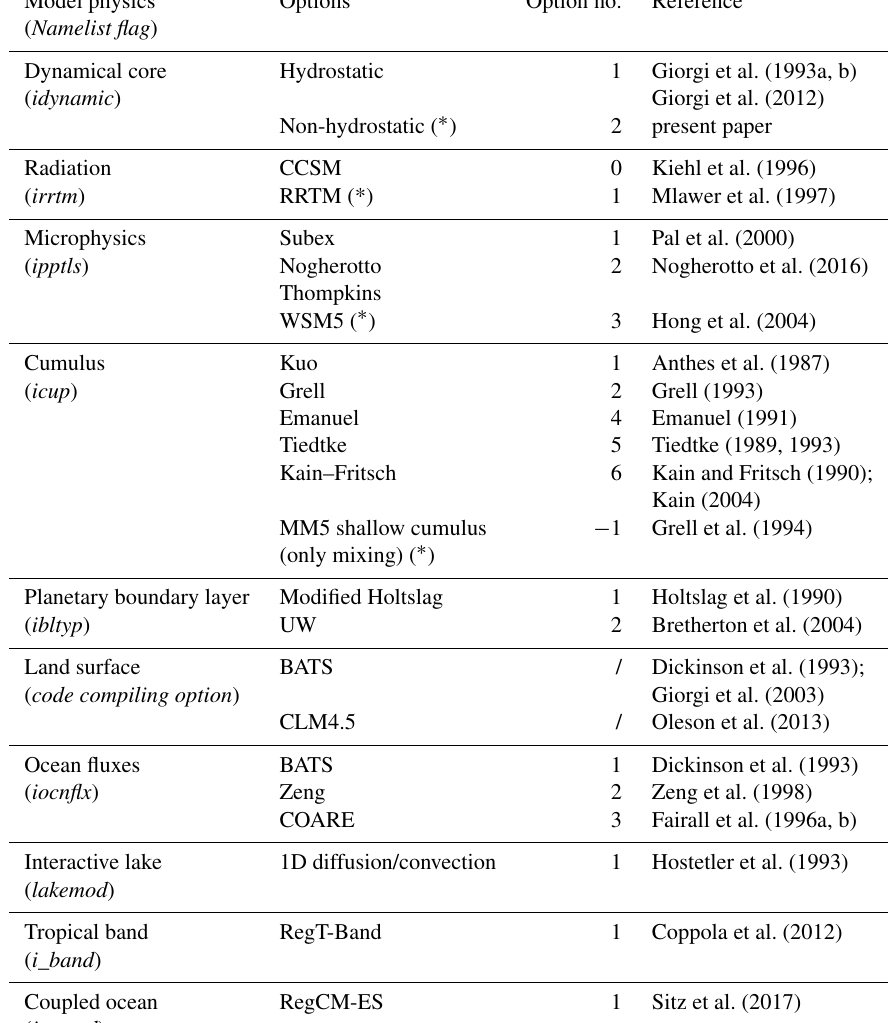
Table 1. Core and sub-grid physics scheme available in RegCM-NH. New schemes available with this release are starred ( ∗ ). Model